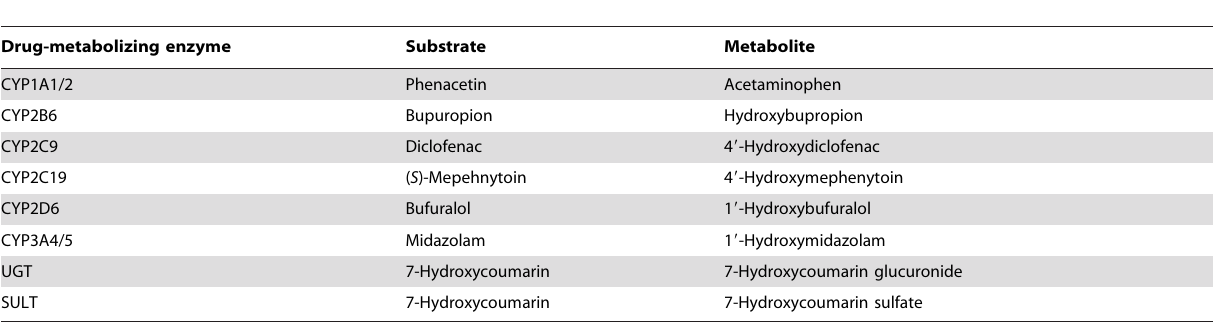
Table 2. Probe substrates of drug-metabolizing enzyme and the